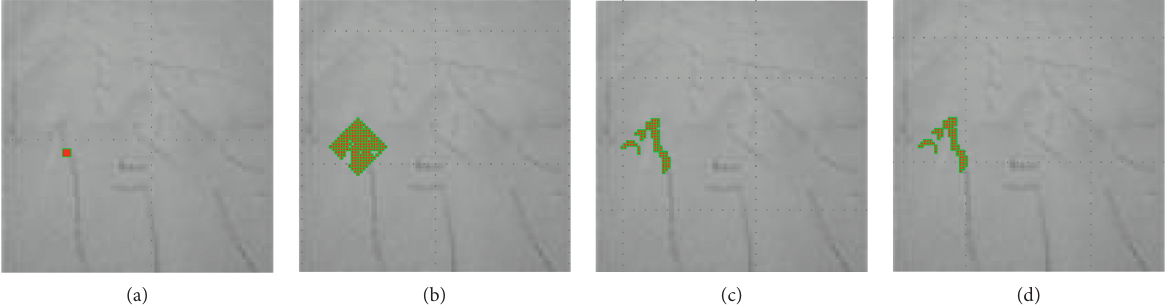
Figure 26: Percolation result of an unclear crack pixel using different striding strategies: (a) raw image; (b) fixed stride percolation; (c) linear stride percolation; (d) quadratic stride percolation.